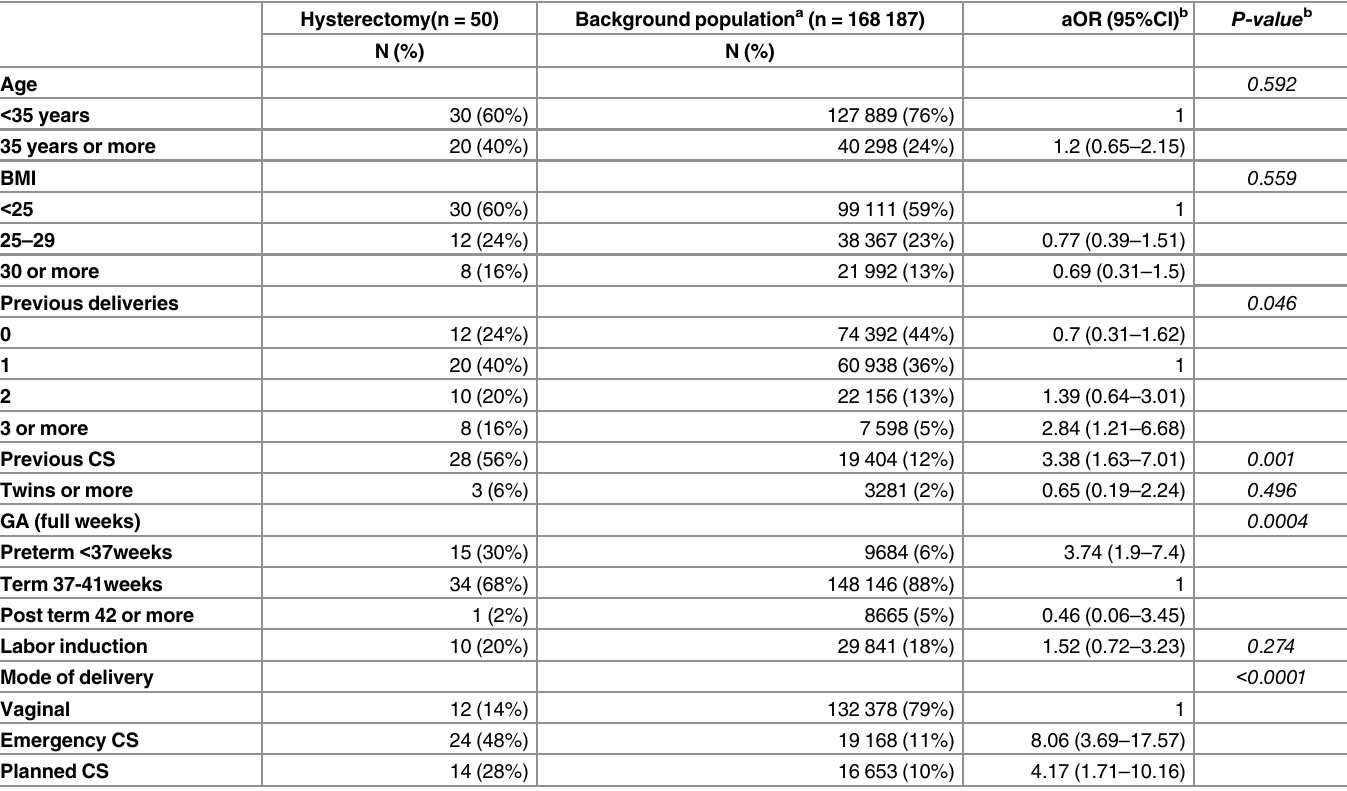
Table 3. Maternal characteristics and risk factors.